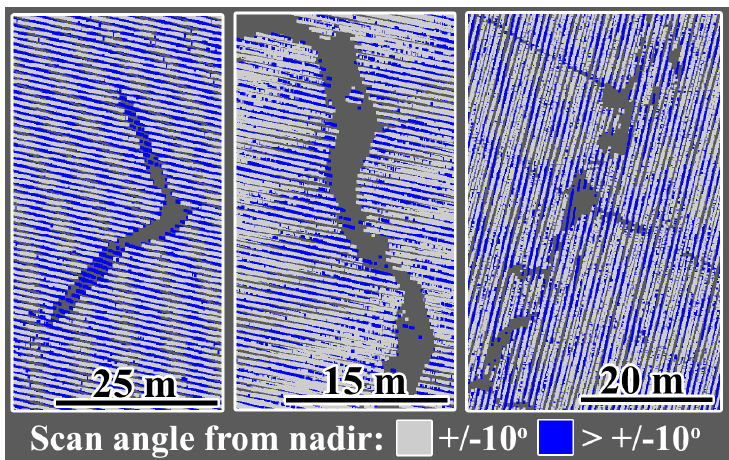
Figure 18. Airborne lidar returns showing examples of creeks and ditches, colored by scan angle. Scan angles more than ±10° from nadir are colored in gray. Some creek and ditch structure is only captured by scan angles less than ±10° from nadir, colored in blue.